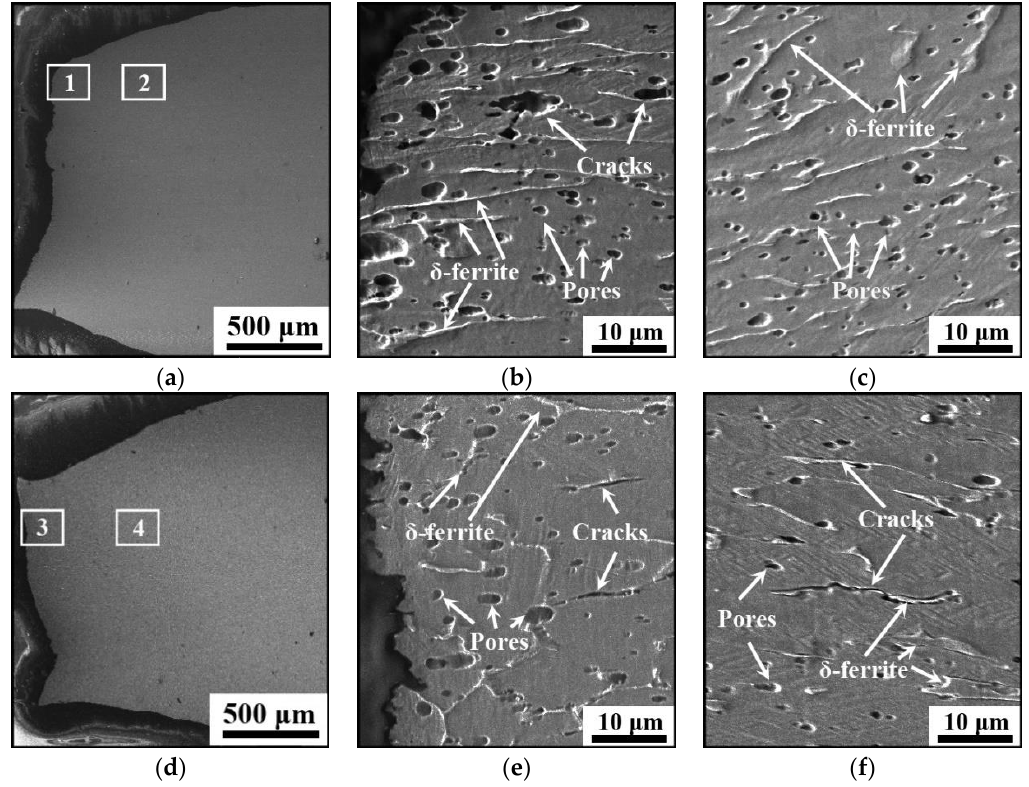
Figure 9. Longitudinal sectional morphologies of the vertical tensile samples under: ( a – c ) low LEI; ( d – f ) high LEI. ( b , c , e , f ) are the magnified graphs of regions marked 1, 2, 3, 4 in ( a , d ).